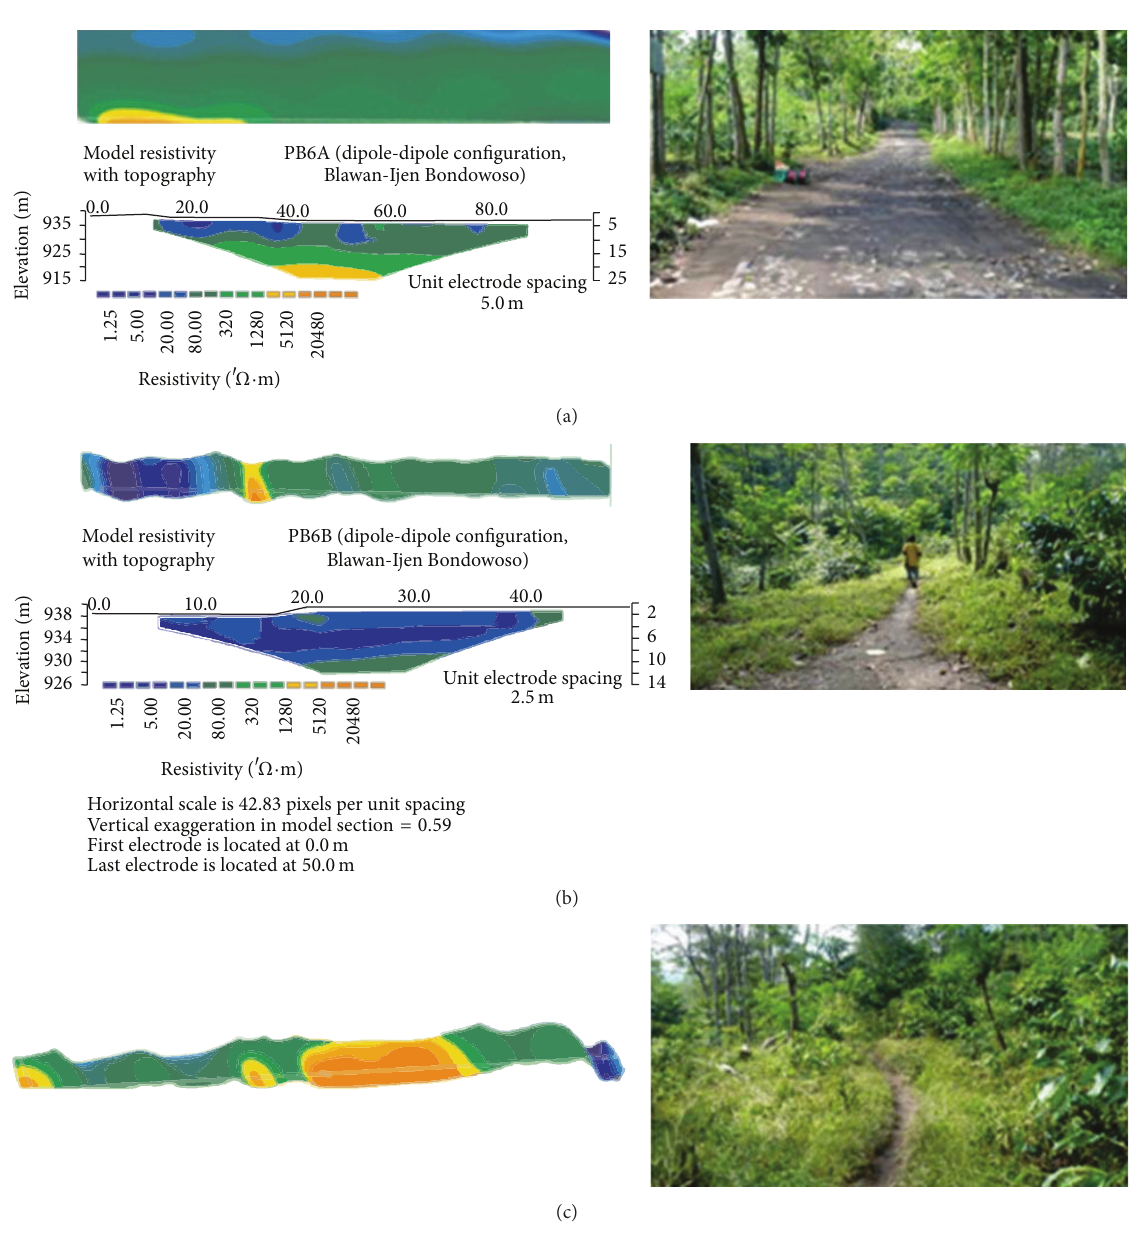
Figure 10: 2D Resistivity Mapping and GPR amplitude slice in locations (a) PB6A, (b) PB6B, and (c) PB6C.